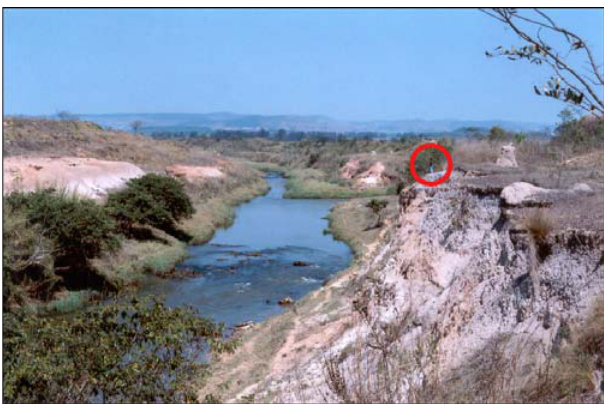
Fig. 4. Transposition canal (foreground) connecting rio Piumhi (formerly part of Paraná system) and Ribeirão da Água Limpa (São Francisco System), downstream from junction of artifi- cial canals draining upper course (right) and reversed lower course (background) of rio Piumhi. Relative height of excava- tion may be estimated from size of adult person standing on top of left bank (indicated by red